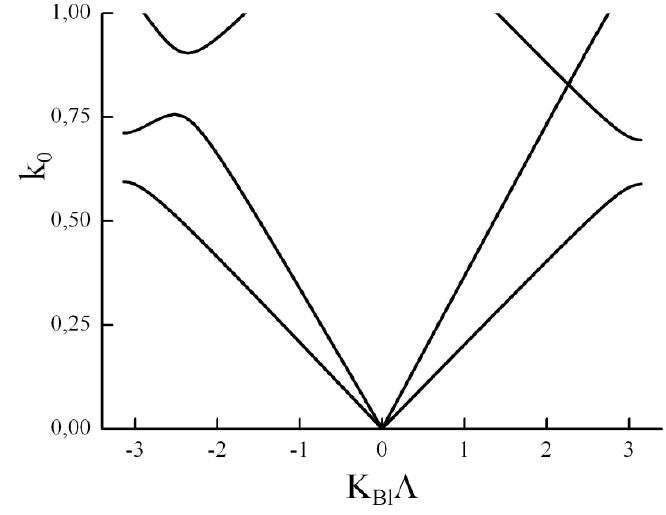
Figure 12. Dispersion curves of a PC with four layers in a unit cell. A DBG exists